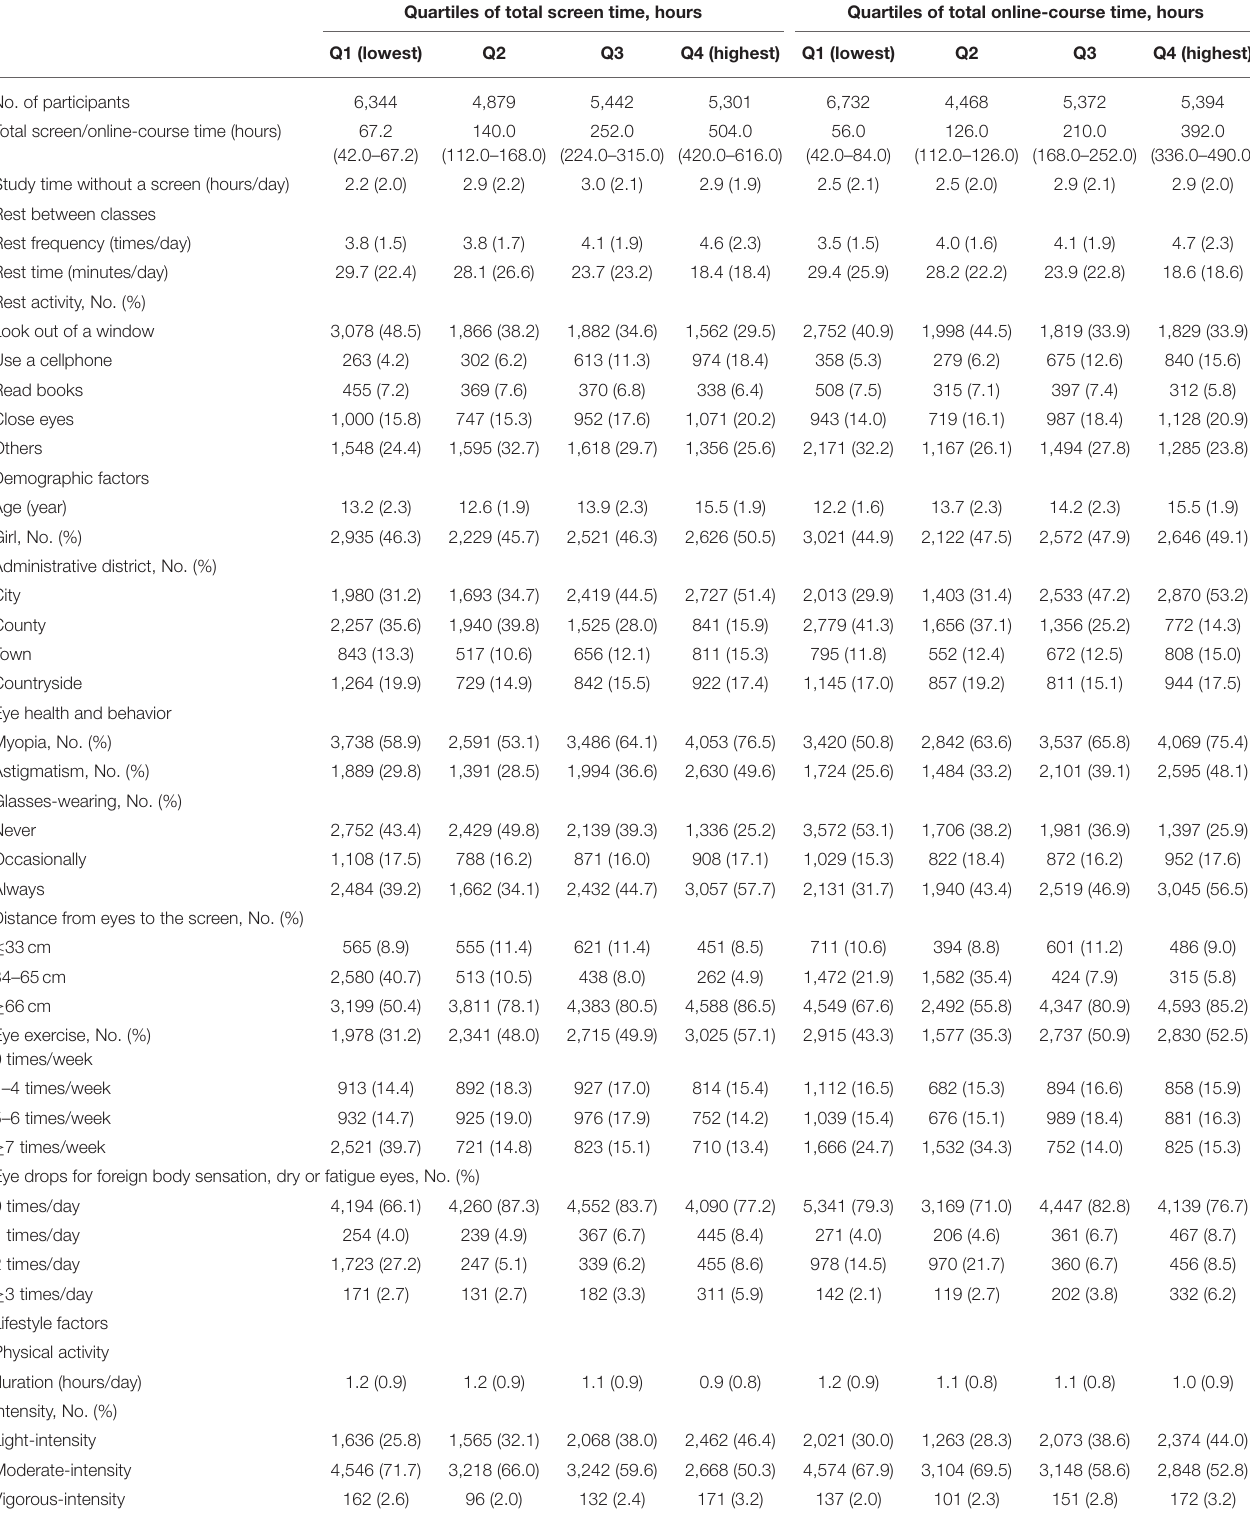
TABLE 2 | Characteristics of the study population by quartiles of total screen time/online-course time a,b . Quartiles of total screen time, hours Quartiles of total online-course time,